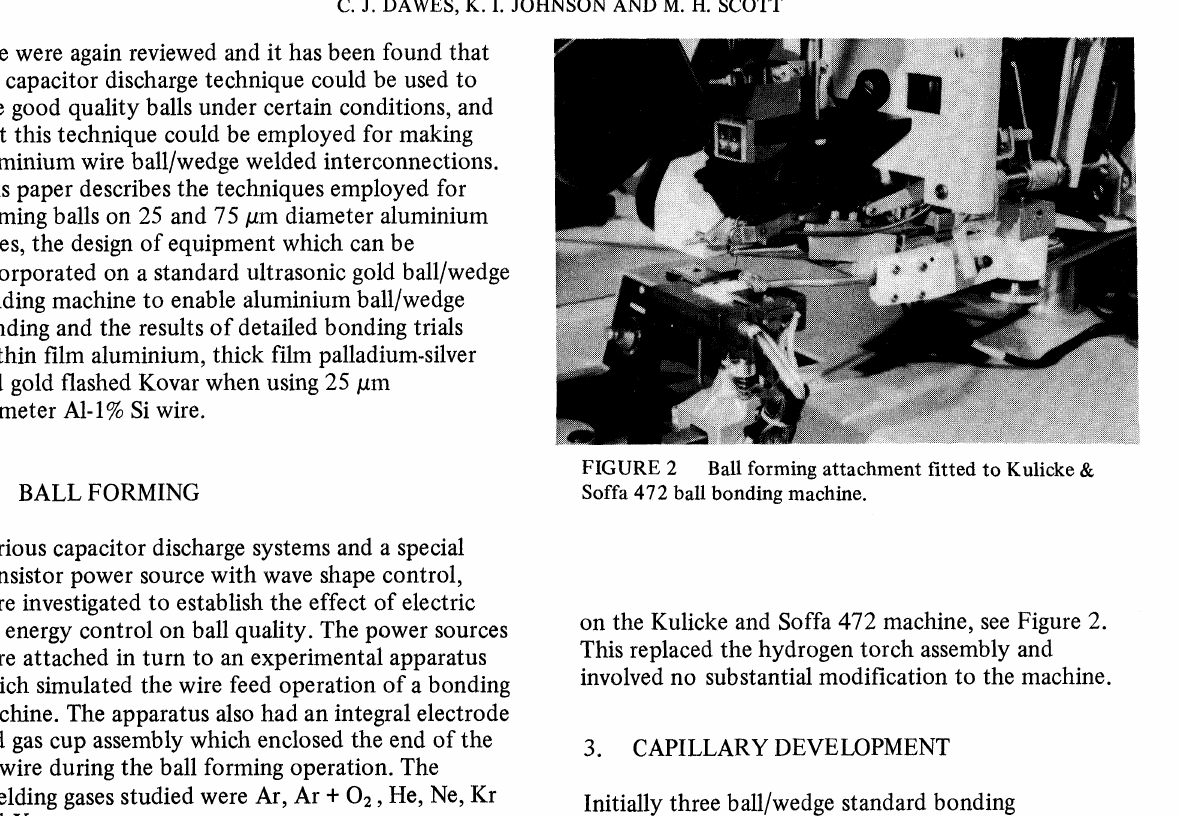
FIGURE 2 Ball forming attachment fitted to Kulicke & Soffa 472 ball bonding machine.